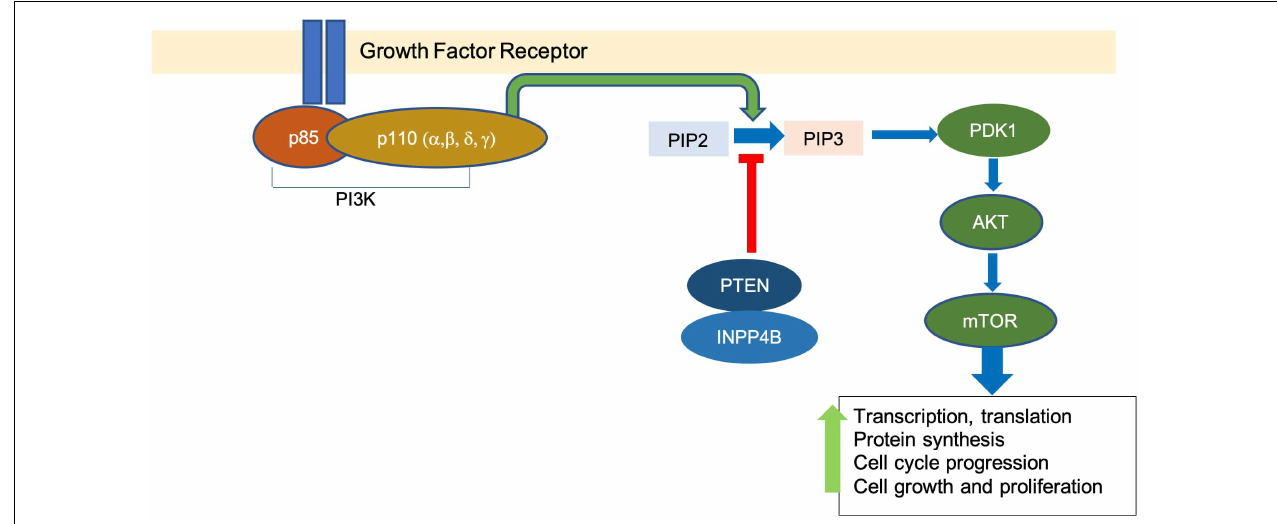
FIGURE 1 | The overview of PI3K pathway. Binding of growth factor activates the tyrosine kinase receptor, which promotes the transformation of PIP2 to PIP3 by PI3K. This leads to a downstream signaling cascade that upregulates events associated with cell growth and